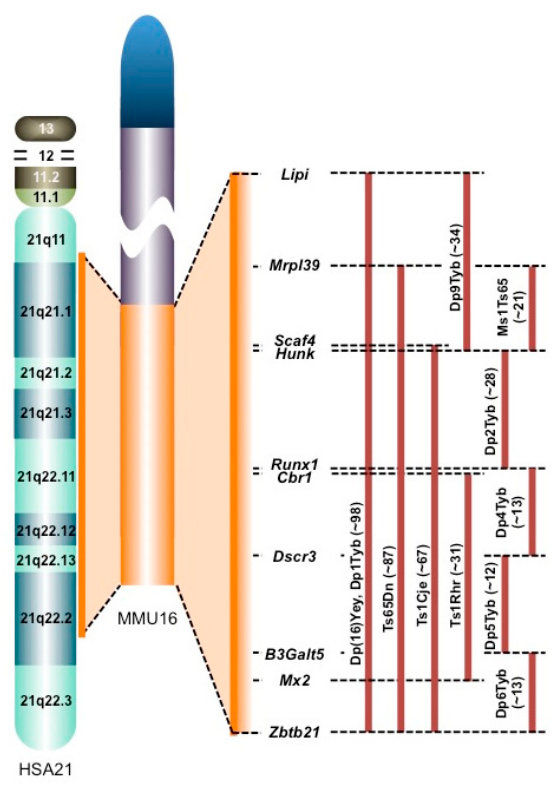
Figure 2. Segmentally trisomic regions of DS mouse models. Most of HSA21 is syntenic to the distal end of MMU16. The trisomic regions in several mouse models of DS are compared on the right of the MMU16 (orange bars). The numbers in brackets represent the number of protein-coding genes within each MMU16 region according to Ensembl release 87. Lipi : lipase, member I, Mrpl39 : mitochondrial ribosomal protein L39, Scaf4 : SR-related CTD-associated factor 4, Hunk : hormonally upregulated Neu-associated kinase, Runx1 : runt-related transcription factor 1, Cbr1 : carbonyl reductase 1, Dscr3 : Down syndrome critical region gene 3, B3Galt5 : UDP-Gal:betaGlcNAc beta 1,3-galactosyltransferase, polypeptide 5, Mx2 : MX dynamin-like GTPase 2, and Zbtb21 : zinc finger and BTB domain containing 21.